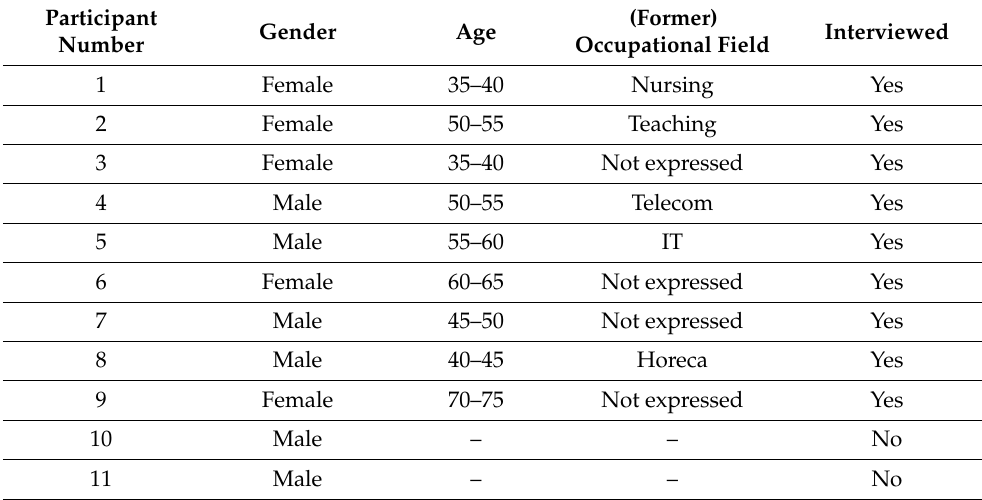
Table 1. Characteristics of study